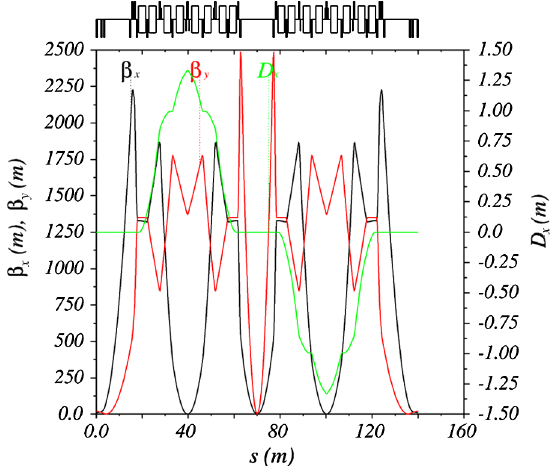
FIG. 5. Complete IR optics of the MEIC ion collider ring. The IP is located at the symmetry point in the